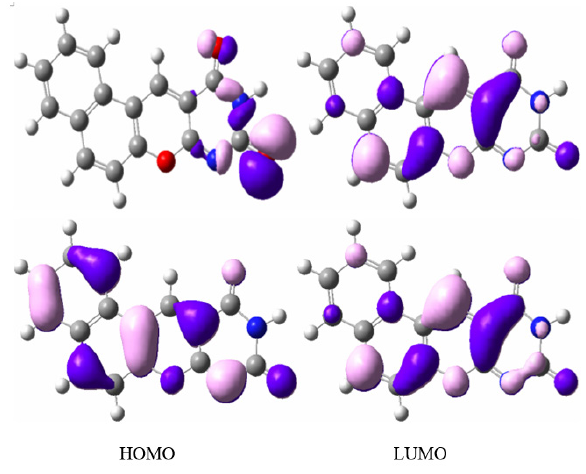
Figure 1: Charge density of HOMO and LUMO at ground (bottom) and excited (top)